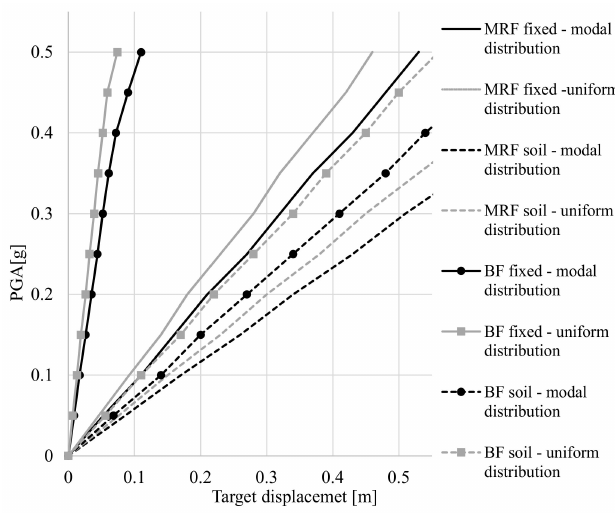
Figure 13. Target displacements for incremental N2